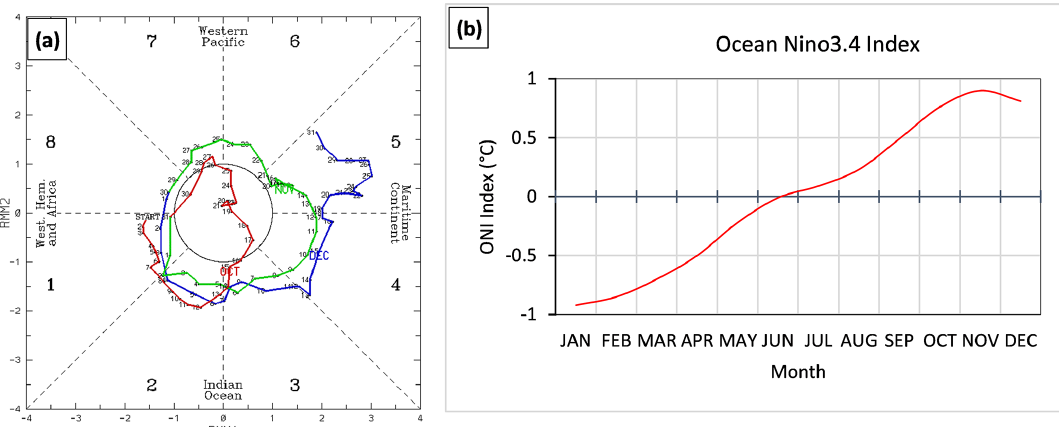
Figure 8. (a) Location of the Madden–Julian Oscillation (MJO) and the strength through eight different areas along the Equator around the globe with labeled dots for each day. The red line is for October, the green line is for November, and the blue line is for December. Source: Commonwealth of Australia 2019, Bureau of Meteorology. (b) The Oceanic Niño Index (ONI) of the Niño 3.4 region (5 ◦ N–5 ◦ S, 120–170 ◦ W) for